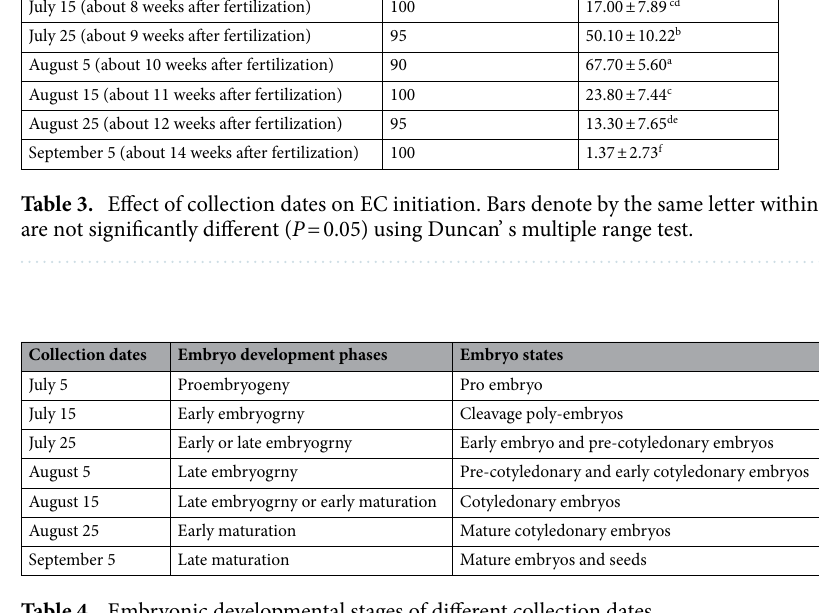
Table 4. Embryonic developmental stages of different collection